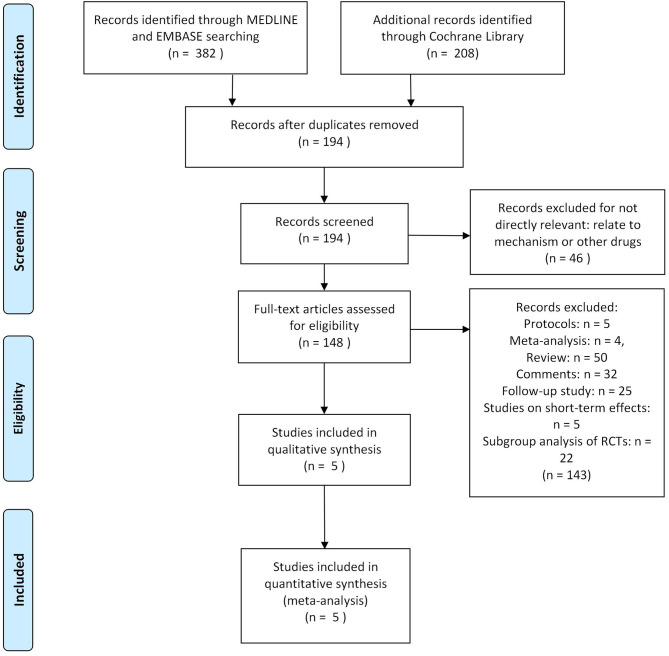
The study search, selection and inclusion process.